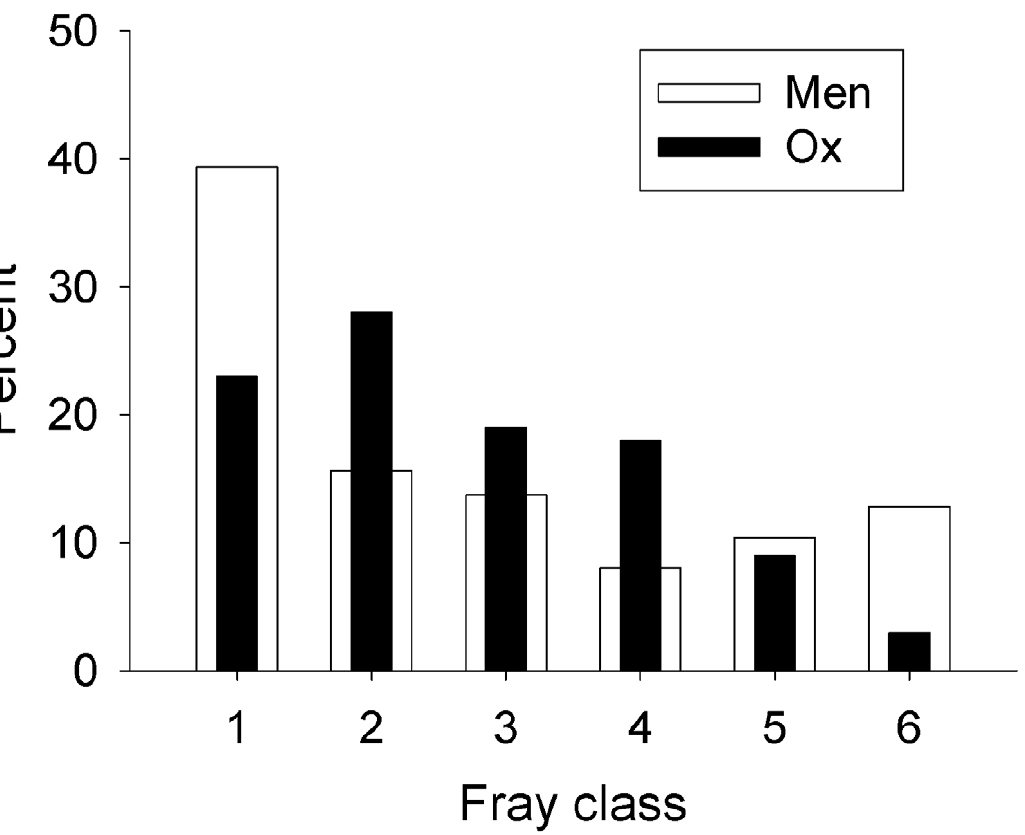
Figure 1. Wing fray classes of male G.m.morsitans caught from men and ox. Percent distribution of wing fray classes of male G. m. morsitans caught from men (N=211) and ox